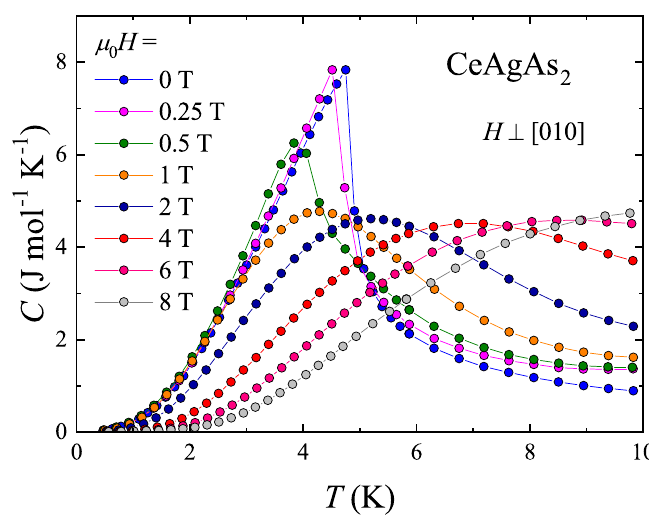
Figure 4. Low temperature specific heat data of single-crystalline CeAgAs 2 measured in zero field and in several finite magnetic fields applied within the (010) plane of the orthorhombic unit cell.